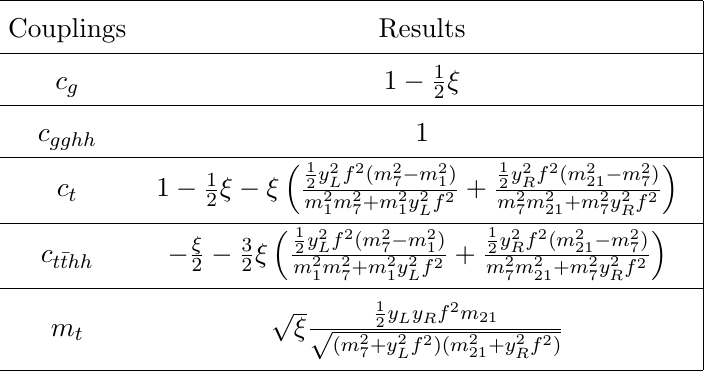
Table 8 . Higgs Couplings and top mass in CTHM of 8 + 28 Representation, which means t L is embedded in the 8 of SO(8) while t R is embedded in the 28 of SO(8).